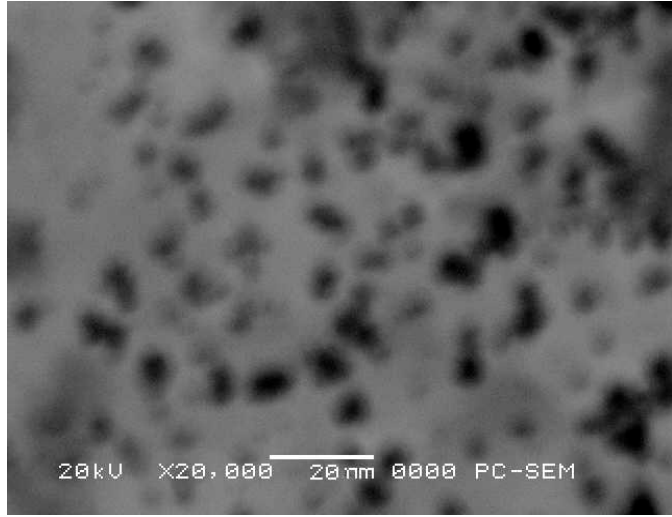
Figure 12. Scanning electron microscopy (SEM) of silver nanoparticles